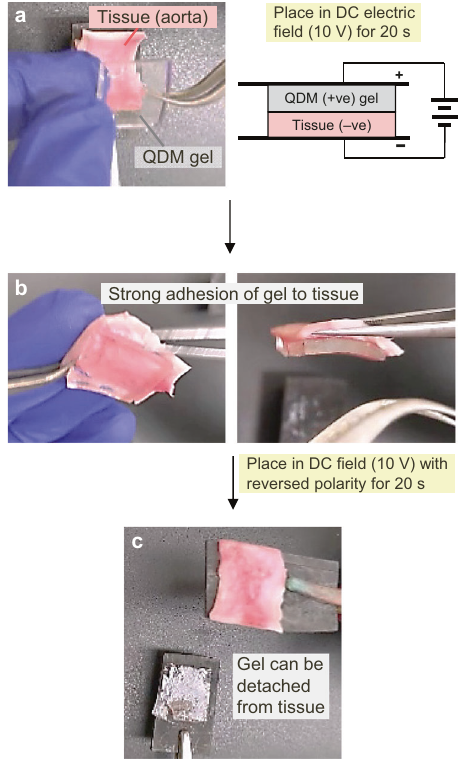
Fig. 5 Electroadhesion of QDM gel to bovine tissue. a A strip of tissue (T − ), speci fi cally bovine aorta, and a strip of cationic QDM gel (G + ) are contacted in a E + G + T − E − con fi guration, with the gel touching the positive and the tissue the negative electrode. 10 V of DC is then applied for 20 s. b This causes the gel to become strongly adhered to the tissue. c When the gel-tissue pair is placed in the fi eld with reversed polarity (E + T − G + E − ), then within 10 s, the adhesion is lost and the gel can be detached from the tissue. The above photos are stills from Supplementary Movie 3.